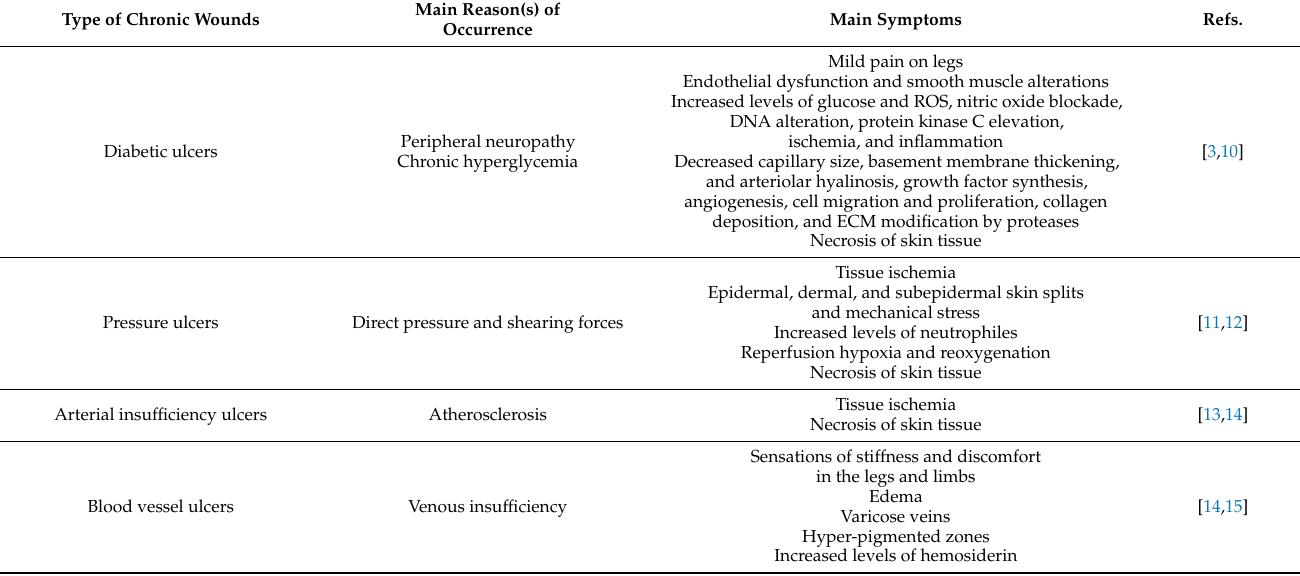
Table 1. Chronic wound